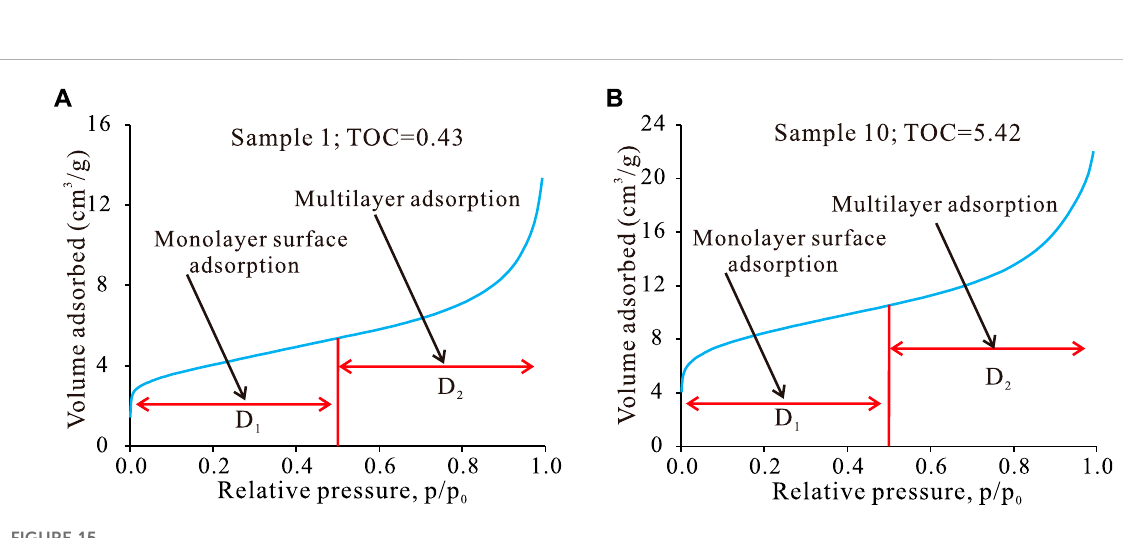
FIGURE 15 Chart showing the adsorption process and the major fractal dimension in (A) sample 1 and (B) sample